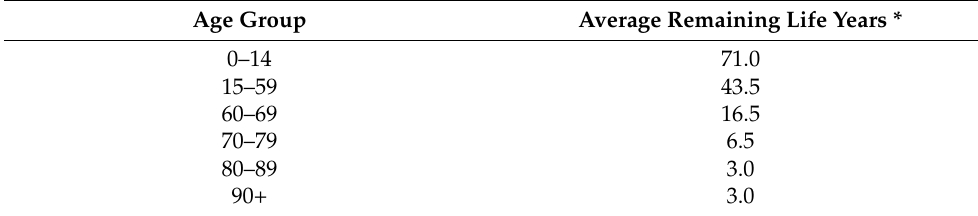
Table 1. Average remaining life